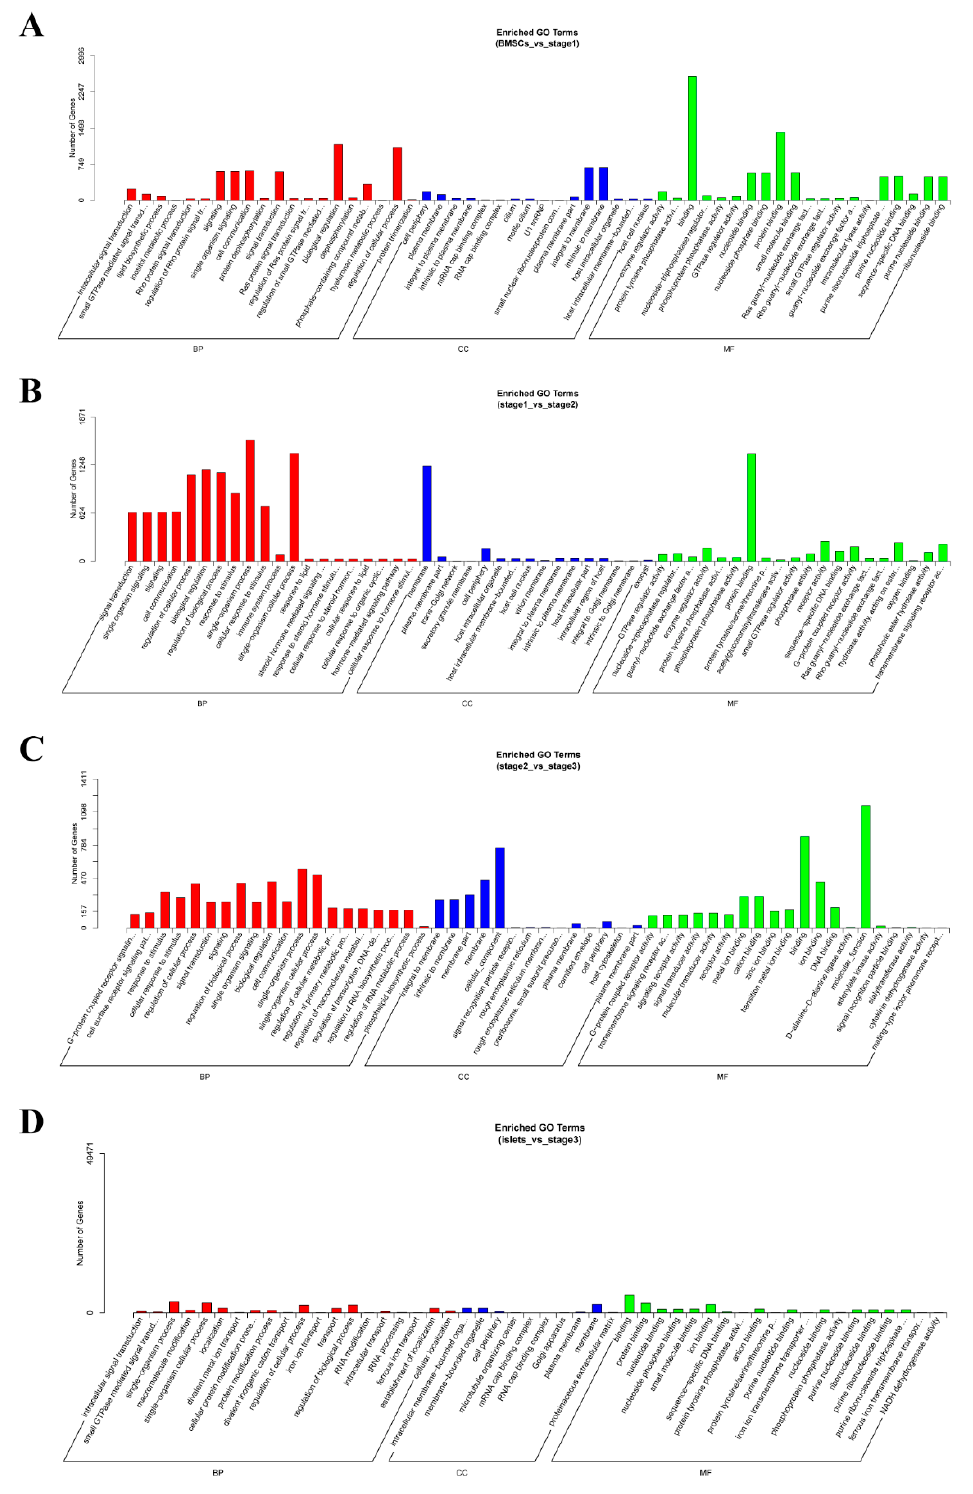
Figure 6. The GO analysis of co-expressed genes of differentially expressed lncRNAs. ( A ) The comparison of B vs. S1. ( B ) The comparison of S1 vs. S2. ( C ) The comparison of S2 vs. S3. ( D ) The comparison of I vs. S3.